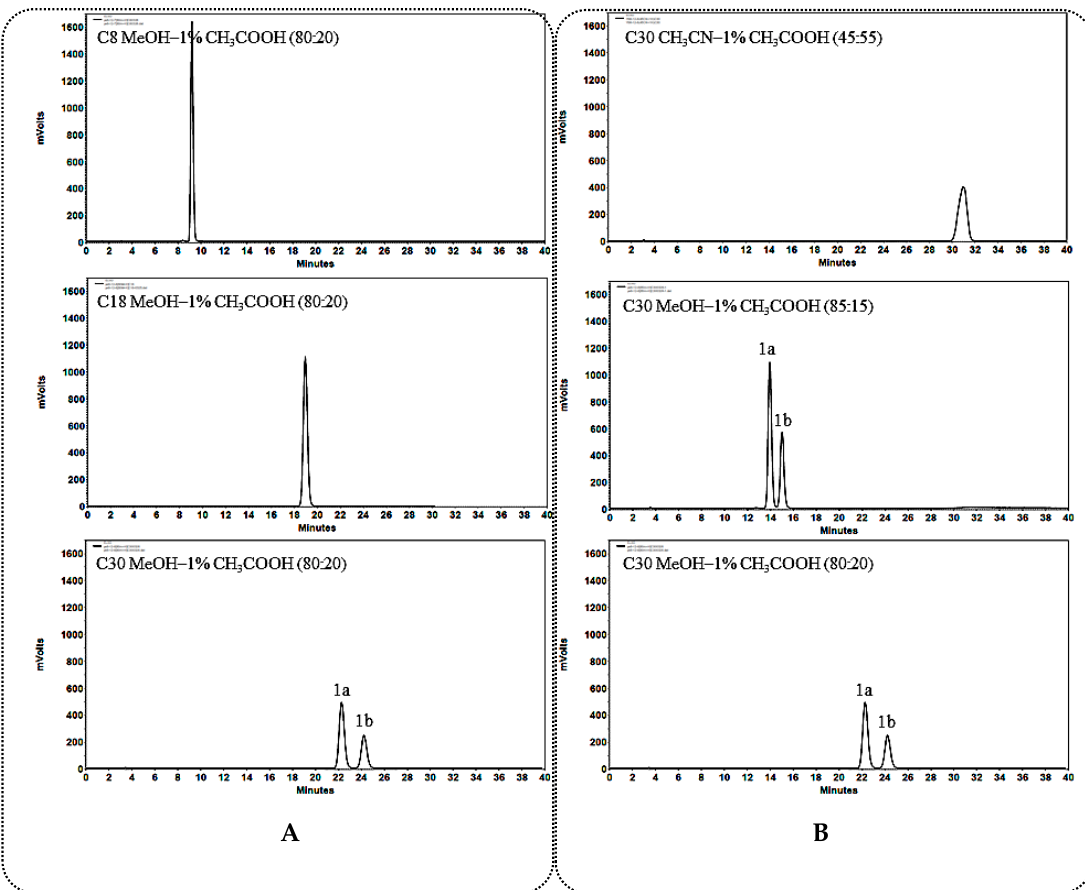
Figure 2. ( A ) Chromatograms of 1a and 1b separated on C 8 , C 18 , C 30 columns; ( B ) Chromatograms of 1a and 1b separated on the C 30 column in different solvent system.